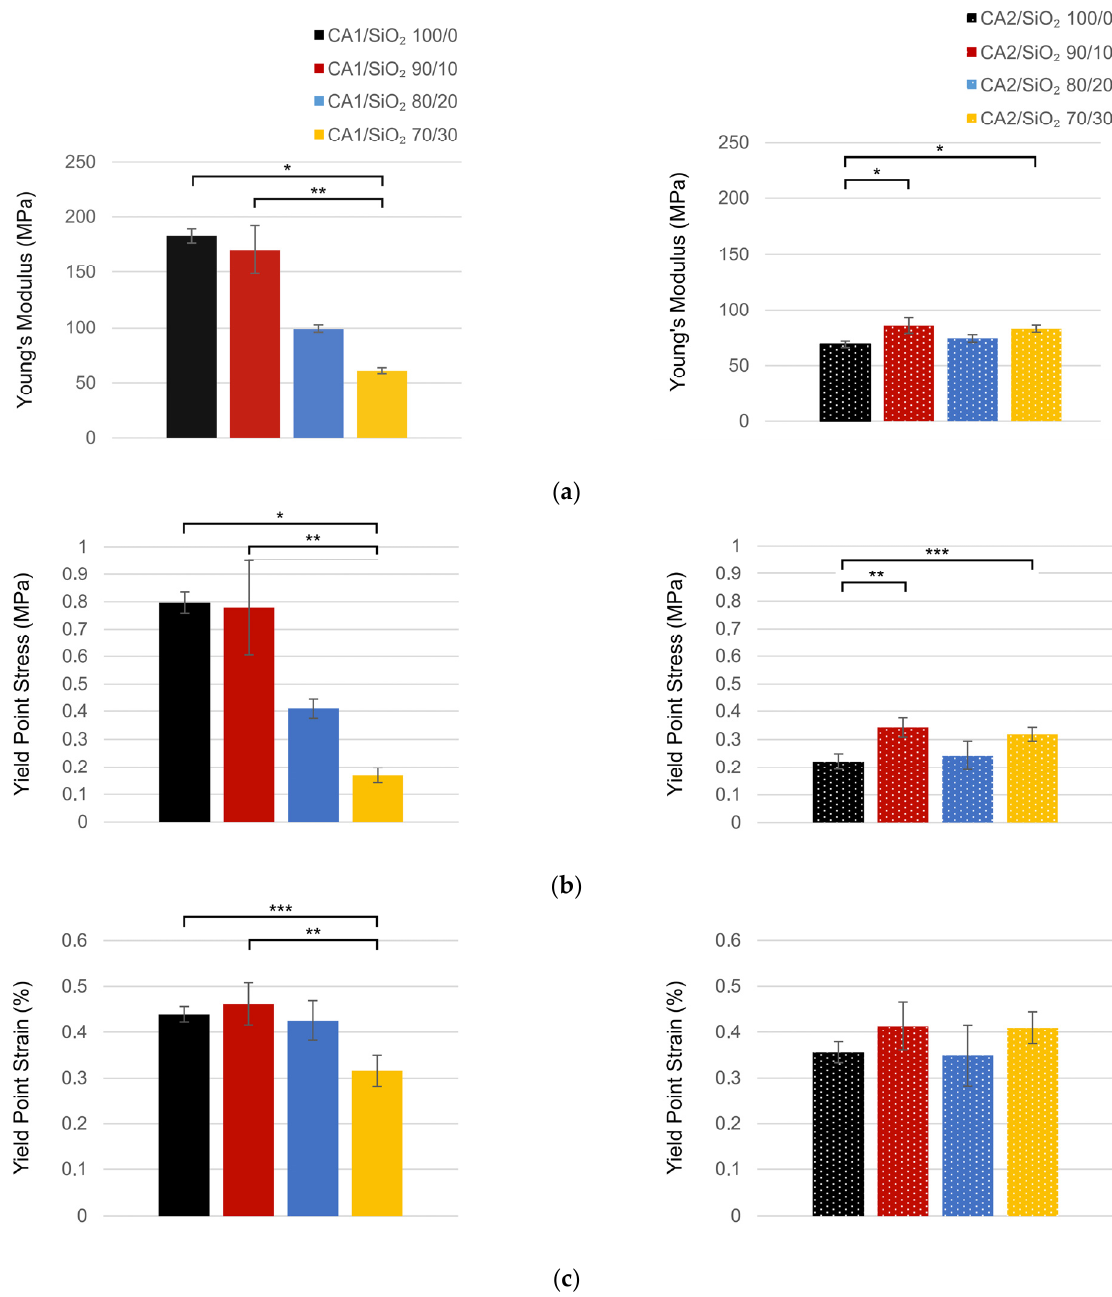
Figure 10. Mechanical properties for series one ( left ) and series two ( right ): ( a ) Young’s modulus ( top ); ( b ) stress at yield point ( middle ); and ( c ) strain at yield point ( bottom ) (* p < 0.01; ** p < 0.05; *** p < 0.1).